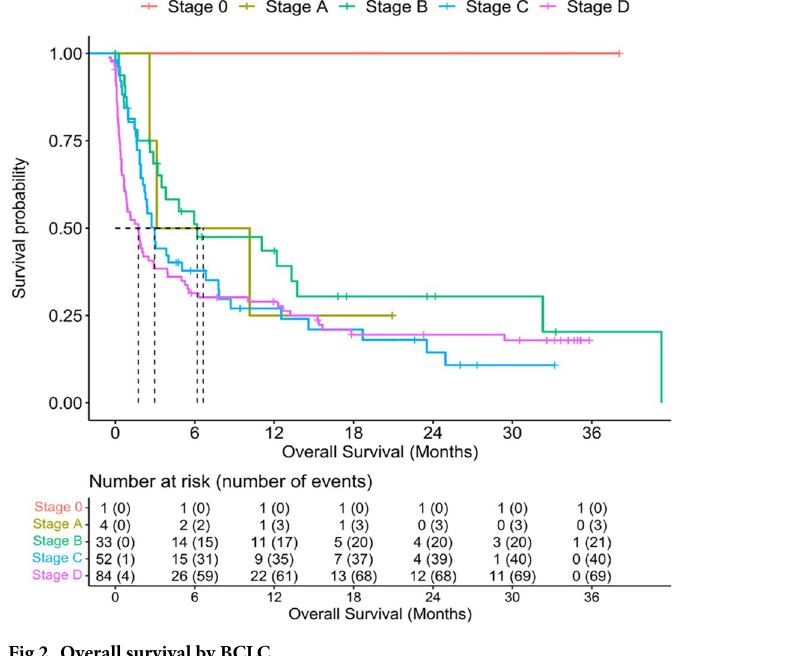
Fig 2. Overall survival by